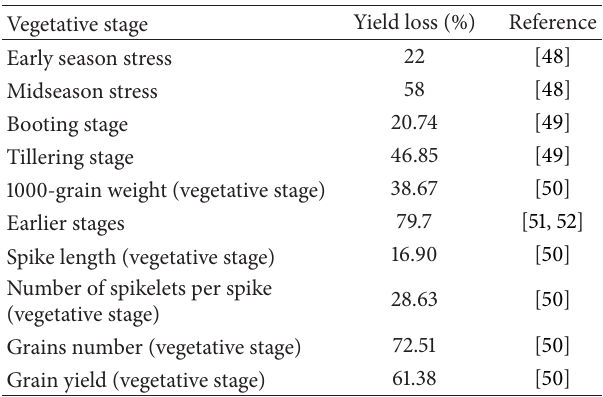
Table 1: Yield losses at vegetative growth stages under drought in wheat.